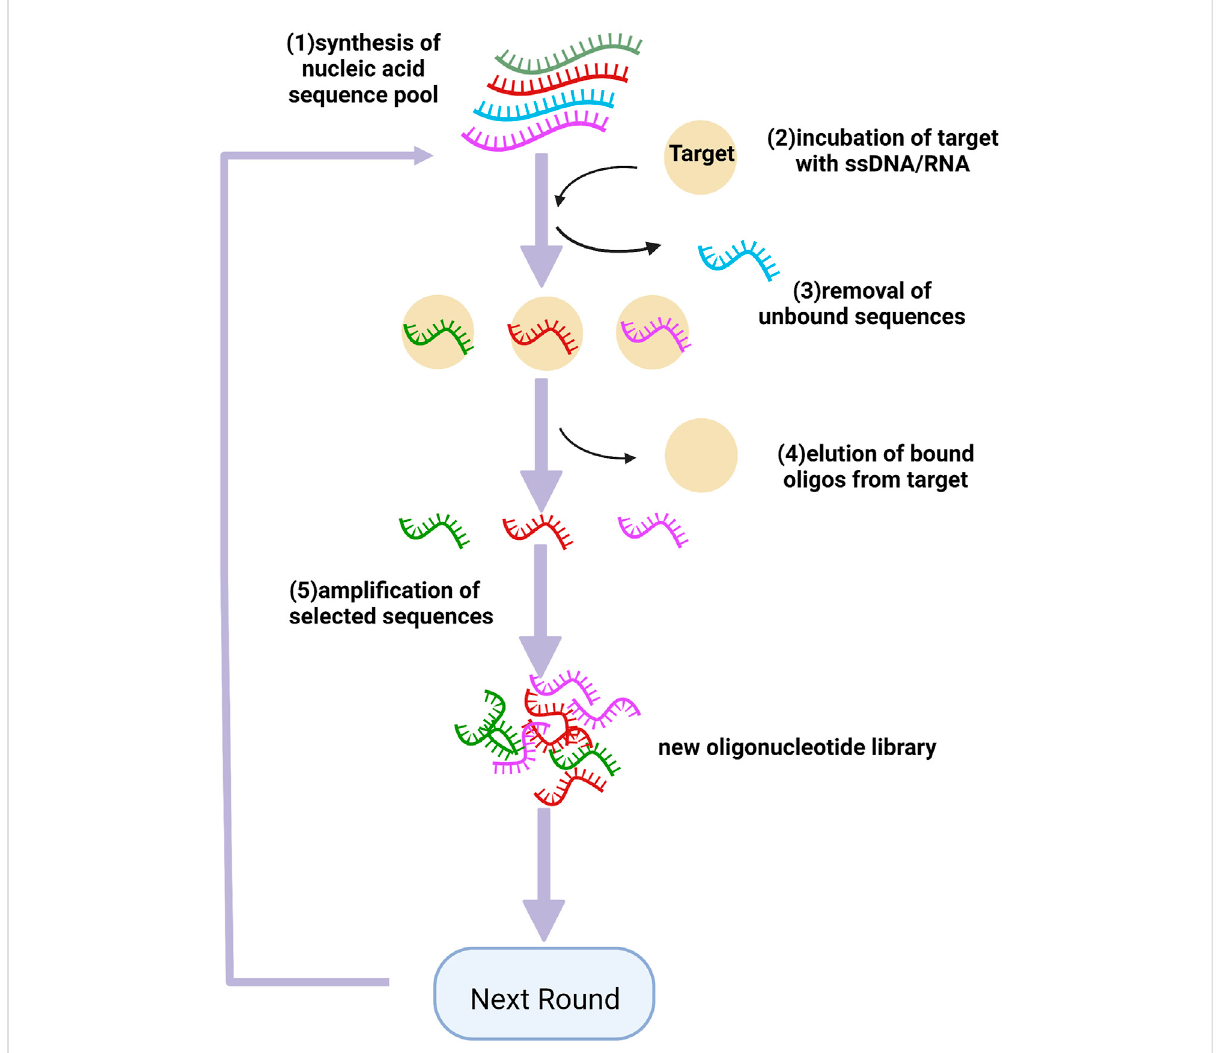
Schematics of SELEX for aptamer selection. (1) synthesis of the nucleic acid pool which contained a central random sequence containing 20 – 50 bases; (2) incubation of target with the library; (3) removing the unbound oligonucleotides from those bound to the target molecule;